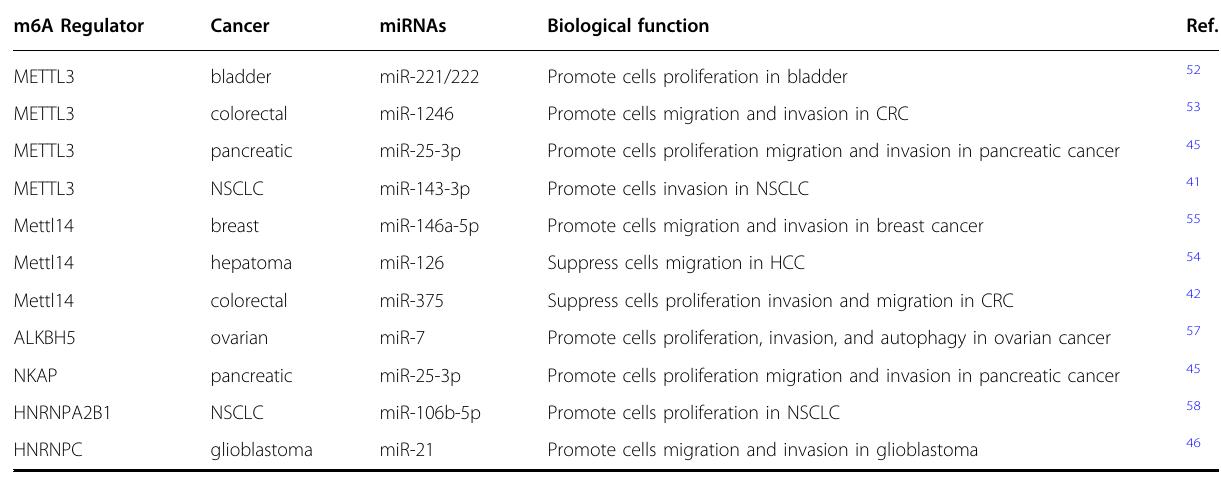
Table 1 M6A regulate miRNAs in different